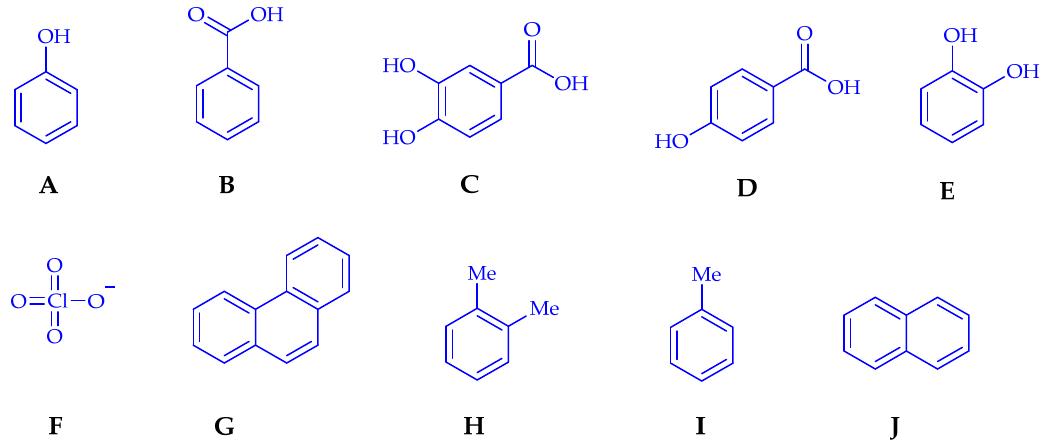
Figure 2. Chemical structures degraded by Azospirillum strains ( A ) phenol, ( B ) benzoate, ( C ) protocatechuate, ( D ) 4-hydroxybenzoate, ( E ) catechol, ( F ) perchlorate, ( G ) phenanthrene, ( H ) xylene, ( I ) toluene and ( J ) naphthalene.